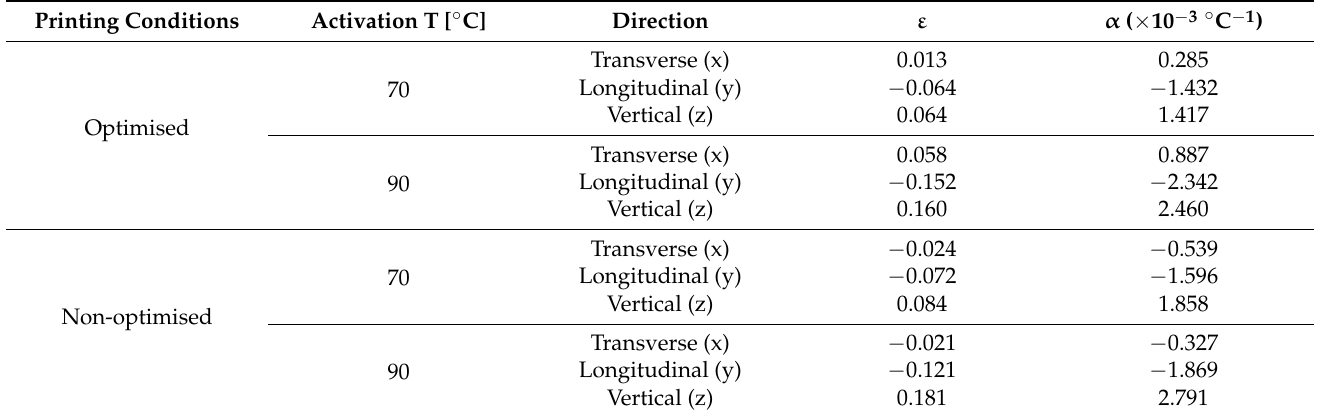
Figure 13. Test samples printed in ( a ) optimised printing conditions and ( b ) non-optimised printing conditions—no exposure (printed and not transformed), 70 and 90 ◦ C (printed and transformed in water at 70 and 90 ◦ C). Table 2. Linear elongation and thermal expansion coefficient of 3D printed test samples in x, y and z